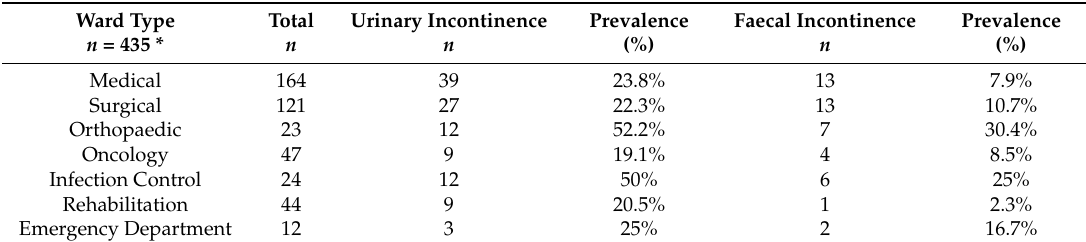
Table 3. Prevalence of Urinary Incontinence and Faecal Incontinence according to ward type. n = 435 *